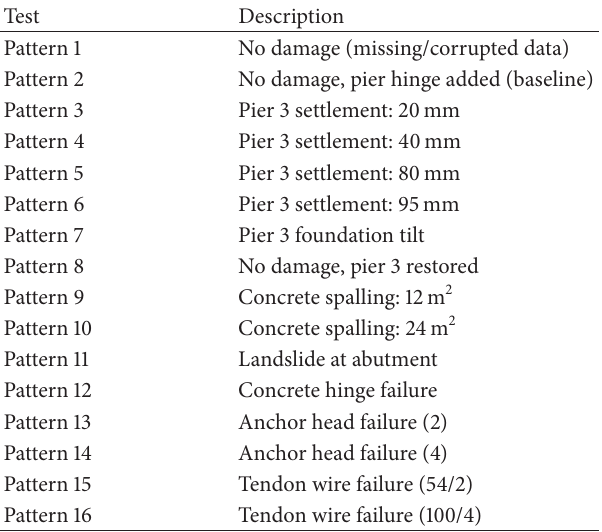
Table 1: Description of progressive damage